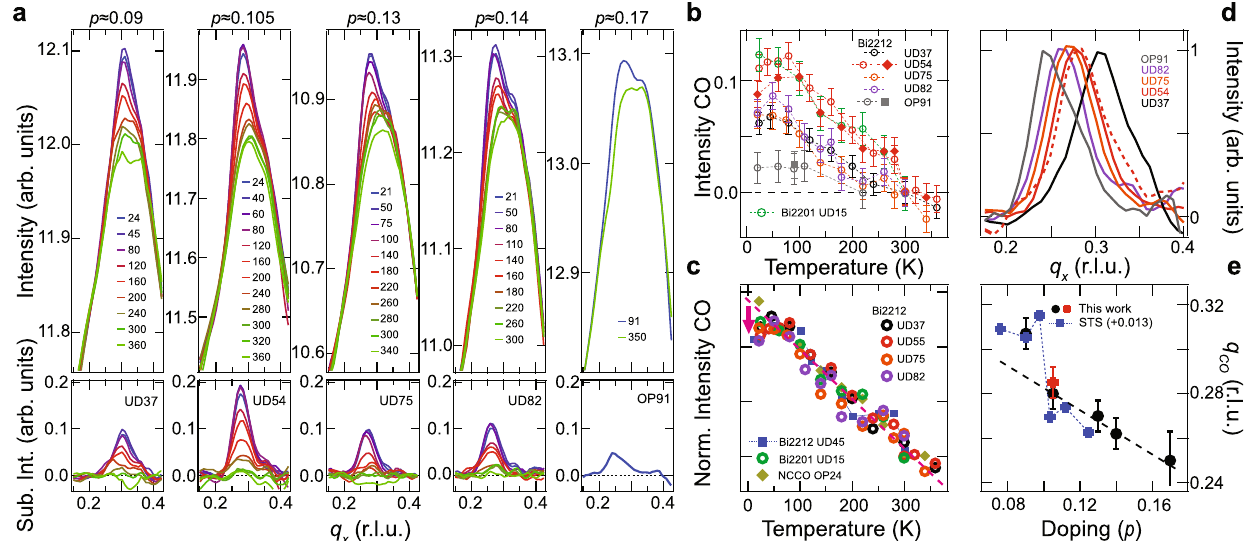
Fig. 3 Temperature and doping dependence of the directionally locked, short-range static charge order. a EI-RXS scattering curves for different hole- concentrations and temperatures (top) and the respective charge order (CO) peaks obtained after subtracting the 300 K data (bottom). b Temperature dependence of the CO intensity for several dopings of Bi2212 and for underdoped Bi2201. The error bars in ( b ) represent the systematic errors associated with the experiment (see Supplementary Note 2). c Temperature dependence of the CO for Bi2212 and Bi2201 at multiple hole doping levels, as well as for the electron-doped cuprate NCCO, scaled to show that the curves collapse on a single line (red dashes) above ~75 K. All samples show a deviation from the linear behavior below 50 K signaling their competition with superconductivity, except for the electron-doped NCCO 16 . The Bi2212 UD45 and NCCO OP24 data are reproduced from refs. 14,59 , respectively. d Low-temperature CO peaks normalized to their peak value showing the doping dependence of q CO . The red dashed and solid curves represent UD54 samples with and without Dy cation substitution, respectively. e CO peak location versus hole doping (holes/Cu) obtained from our bulk-sensitive experiments compared to the q CO values obtained from surface-sensitive STS experiments reported in ref. 14 . The red and black points for p = 0.105 represent samples with and without Dy cation substitution, respectively. The dashed line in e is a guide to the eye. The labels indicate under (UD) and optimally doped (OP) followed by the value of their superconducting transition temperature. The error bars in ( e ) represent the 99% con fi dence interval of q CO values retrieved by fi tting with a Gaussian